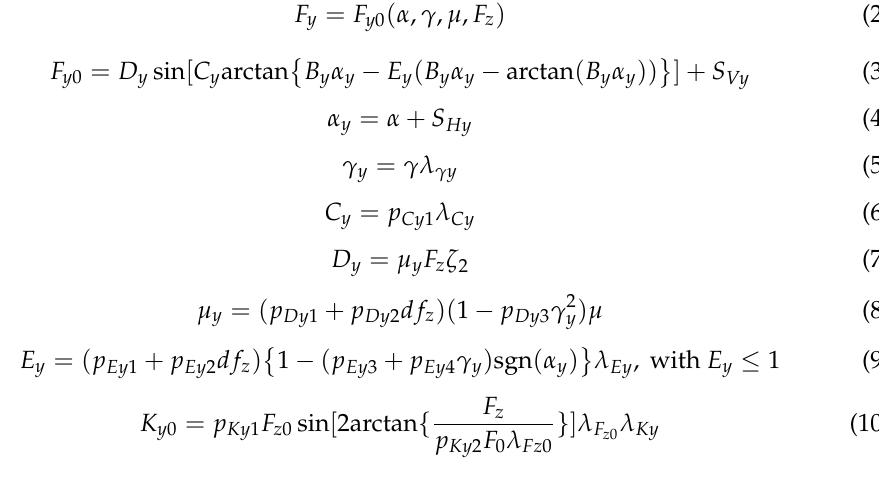
Table 3. Symbols used in the vehicle model.